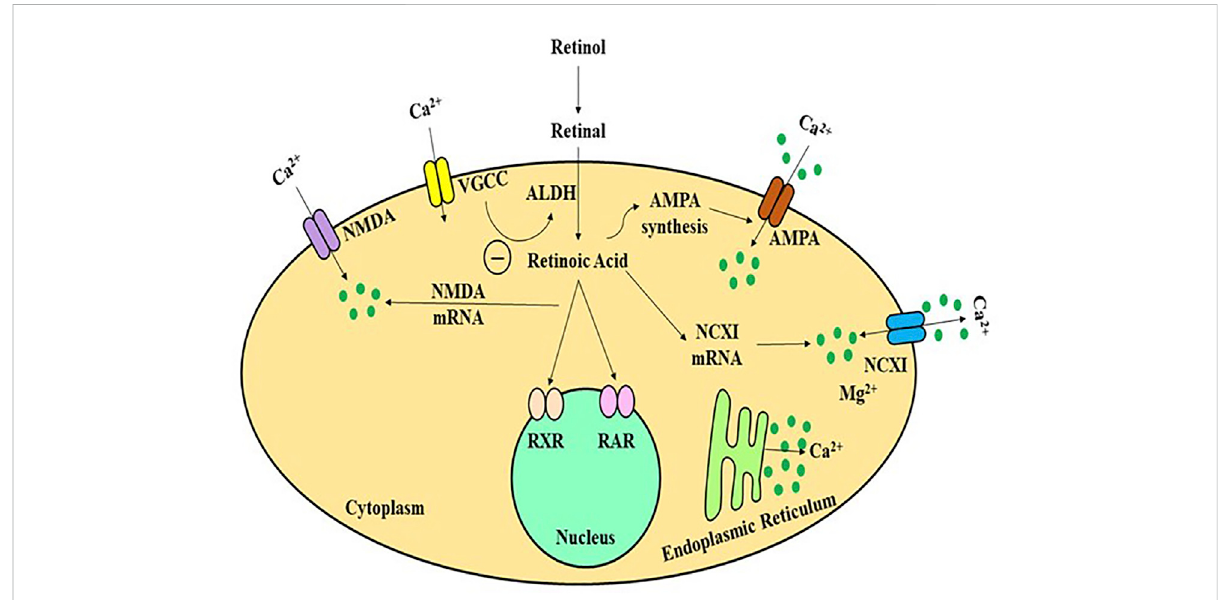
FIGURE 4 A schematic framework of activity-dependent retinoid generation in neurons. Appropriate synaptic transmission inhibits RA production in a Ca 2+ -dependent manner byactivating glutamatereceptorsandL-typeCa 2+ channels.Limitingglutamatereceptors orL-typeCa 2+ channels reduces dendriticL-typeCa 2+ intakeandde-repressesretinoidproduction,allowingAMPARstobetranslatedandinsertedsynapticallyneuralcellstoincrease the calcium in fl ux. ALDH, alcohol dehydrogenase; AMPA, amino-hydroxy-methyl-isoxazolepropionic acid receptor; NMDA, N-methyl-D- aspartate receptor; VGCC, volatge gated calcium channel; RAR/RXR, retinoic acid